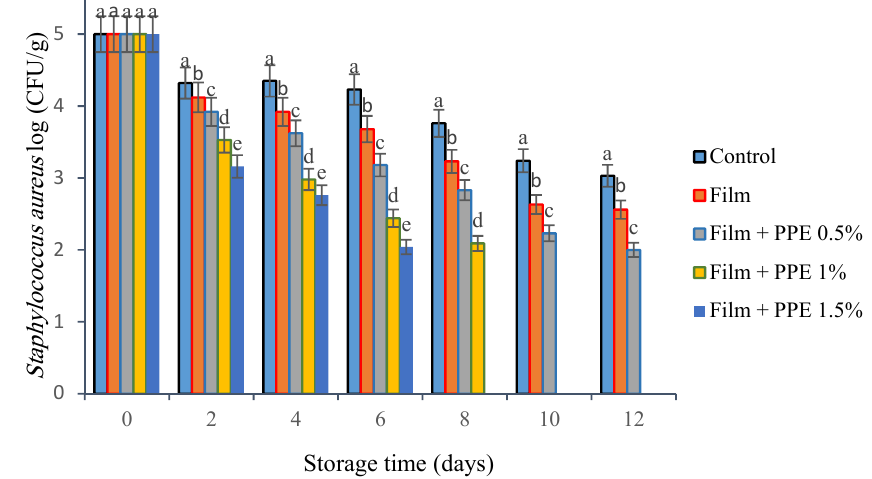
Fig. 6. Changes in Staphylococcus aureus of raw rainbow trout fillets packed in chitosan-ZnO films containing different concentrations of pomegranate peel extract (PPE) during refrigerated storage. Each number is the mean ± standard error taken from different experiments. a–e For each day, columns representing different bacterial population are labeled with different letters (P < 0.05)